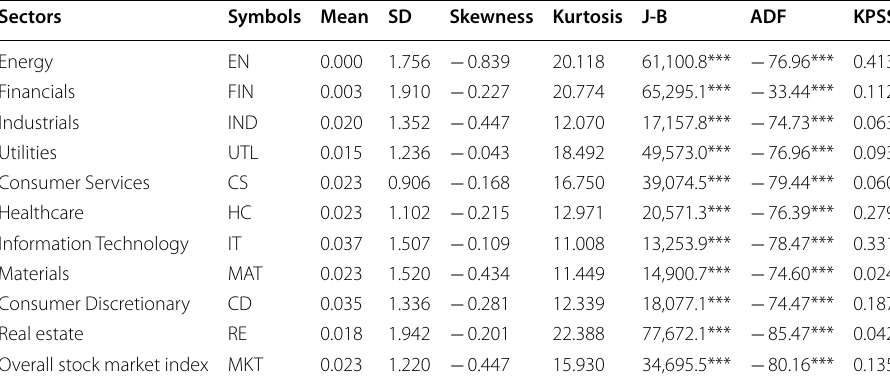
J–B stands for Jarque–Bera test of normality. ADF and KPSS test unit root and stationarity, respectively *** Indicates rejection of null hypothesis of normality and unit root at 1% level of